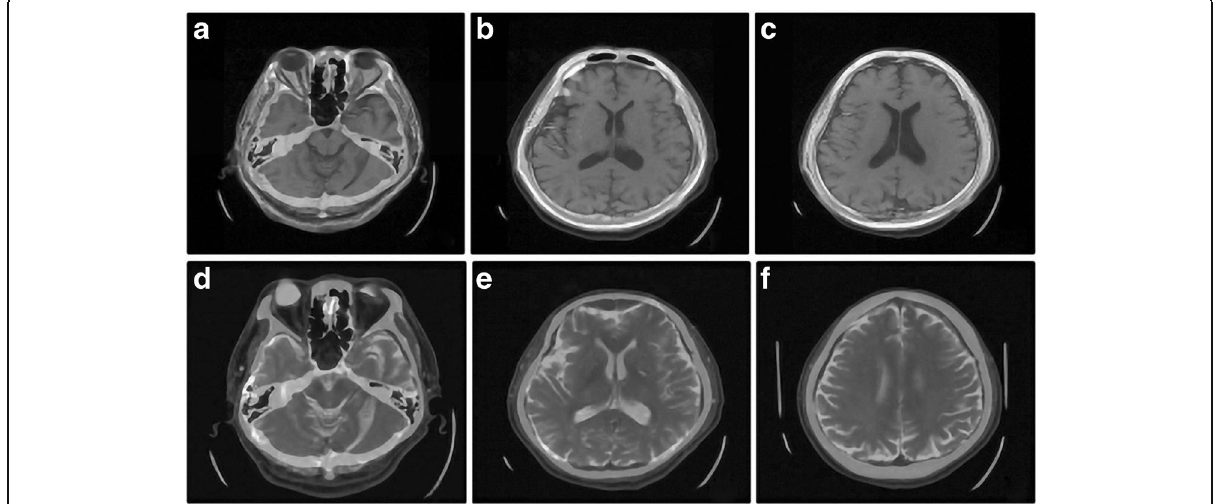
Fig. 17 The wavelet-weighted maximum fusion result of patient